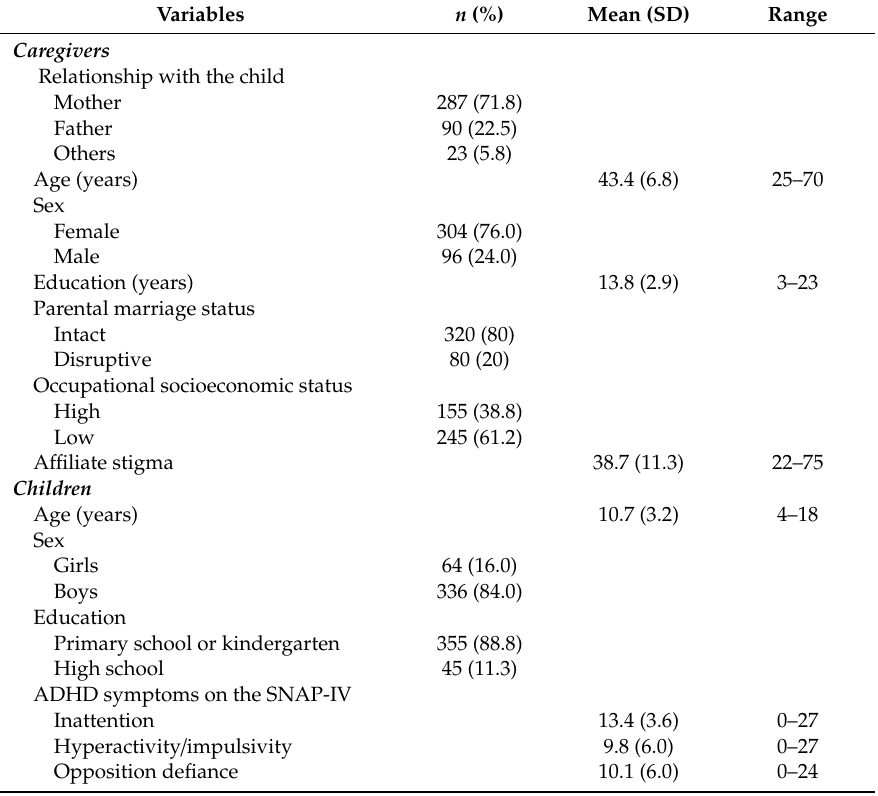
Table 1. Caregivers’ demographic characteristics and a ffi liated stigma and children’s demographic characteristics and ADHD symptoms (N =